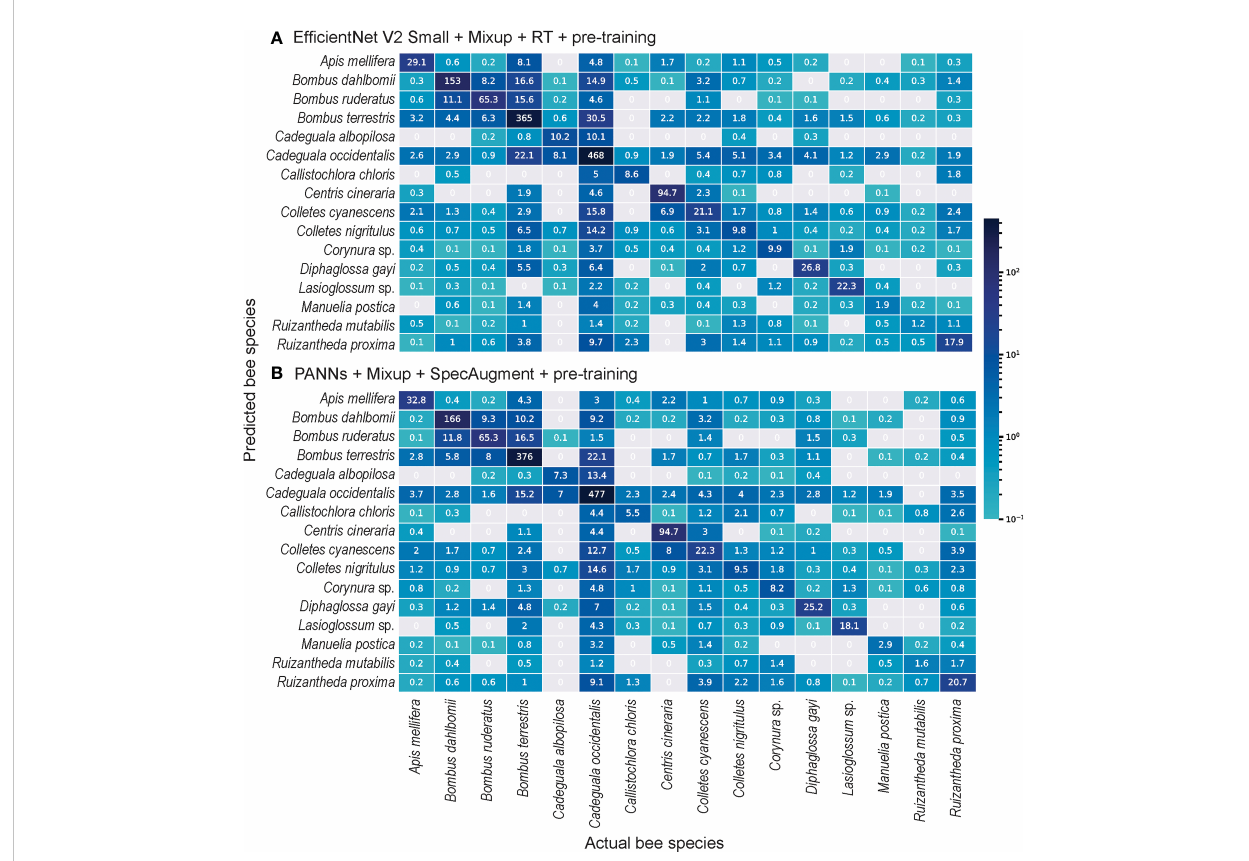
FIGURE 3 Confusion matrices showing the log-transformed number of audio samples correctly assigned to respective bee identity (diagonal elements) versus those erroneously assigned (out-of-diagonal elements) by the DL classi fi ers. (A) Ef fi cientNet V2 Smallcombined with Mixup and RT data augmentation techniques with pre-training achieved the best performance at acoustic recognition of bees visiting fl owers of blueberry crops, followed by (B) PANNs combined with Mixup and SpecAugment with pre-training. Cellcolor represents the corresponding number (log-transformed) of audio segments predicted in a given cell, ranging from gray (zero predicted audio segments) to dark